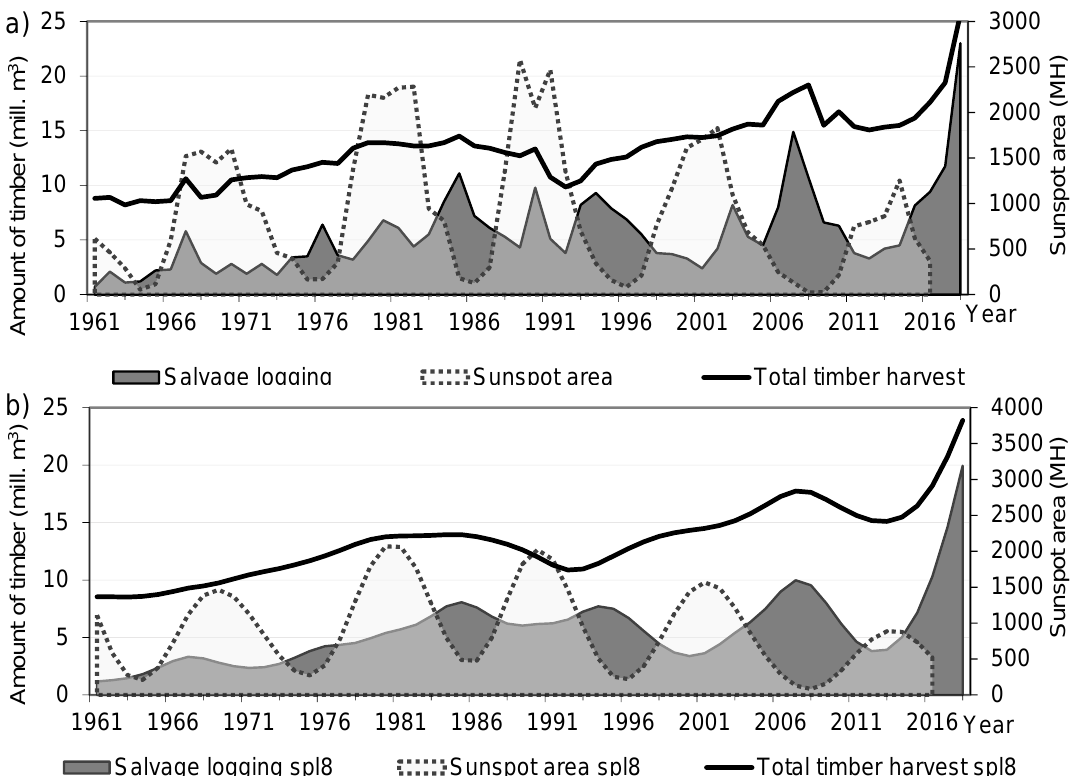
Figure 6. The average annual area of sunspots in relation to the volume of timber harvested in the Czech Republic: ( a ) The trend of total harvested timber and salvage logging according to their causes in relation to the sunspot area; ( b ) an eight-year spline (spl8) fitted to harvested timber and sunspot area; MH—millionths of a hemisphere; mill. m 3 —million cubic meters of harvested timber.